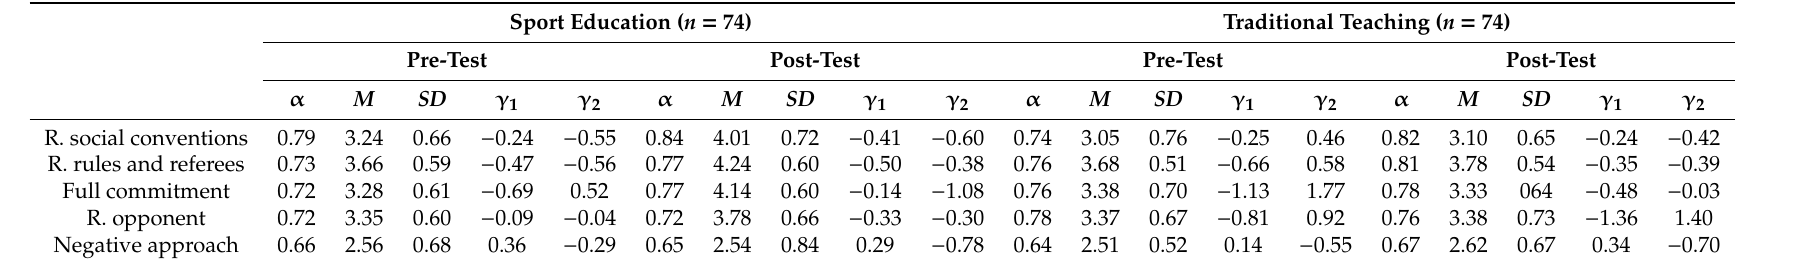
Table 2. Descriptive statistics and reliability coe ffi cients for the Sport Education and Traditional Teaching